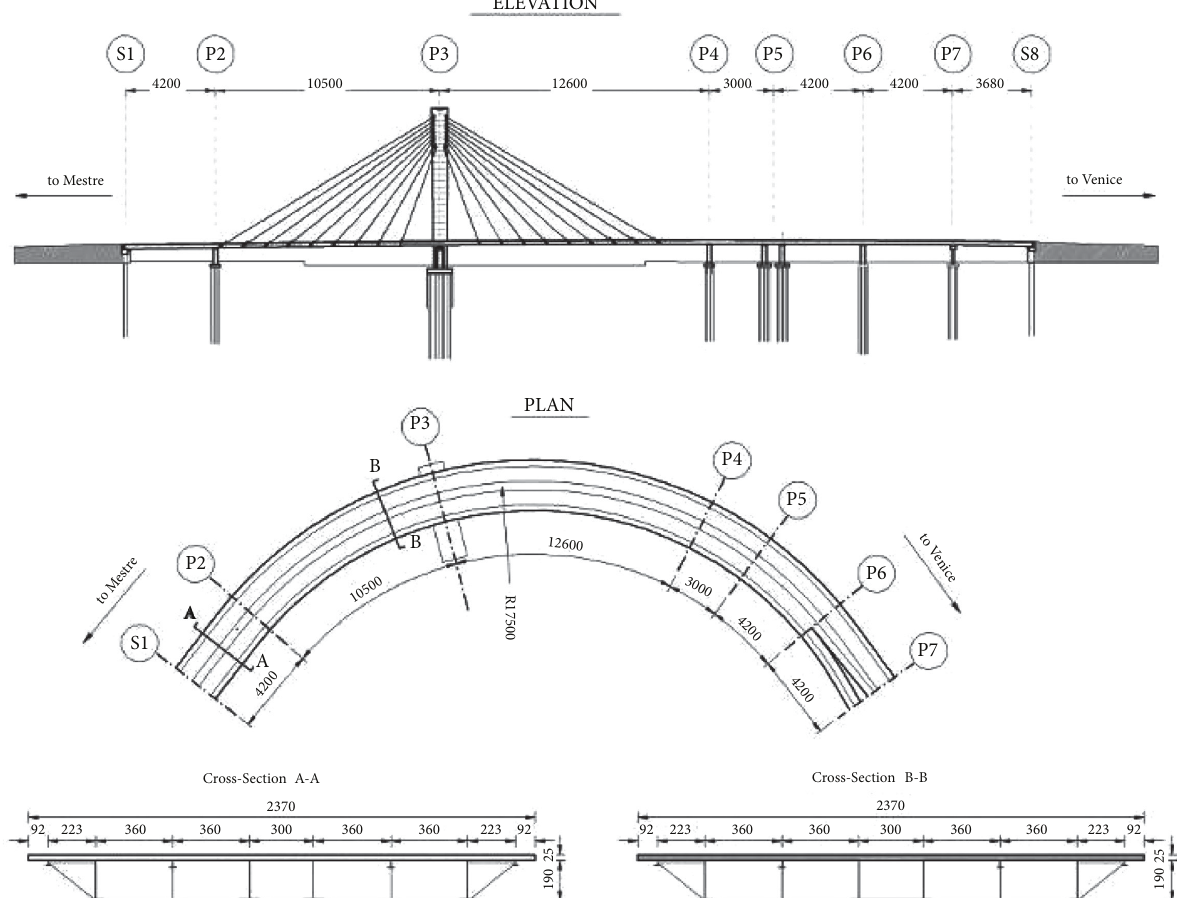
Figure 8: Plan view, elevation view, and typical deck cross sections (units in